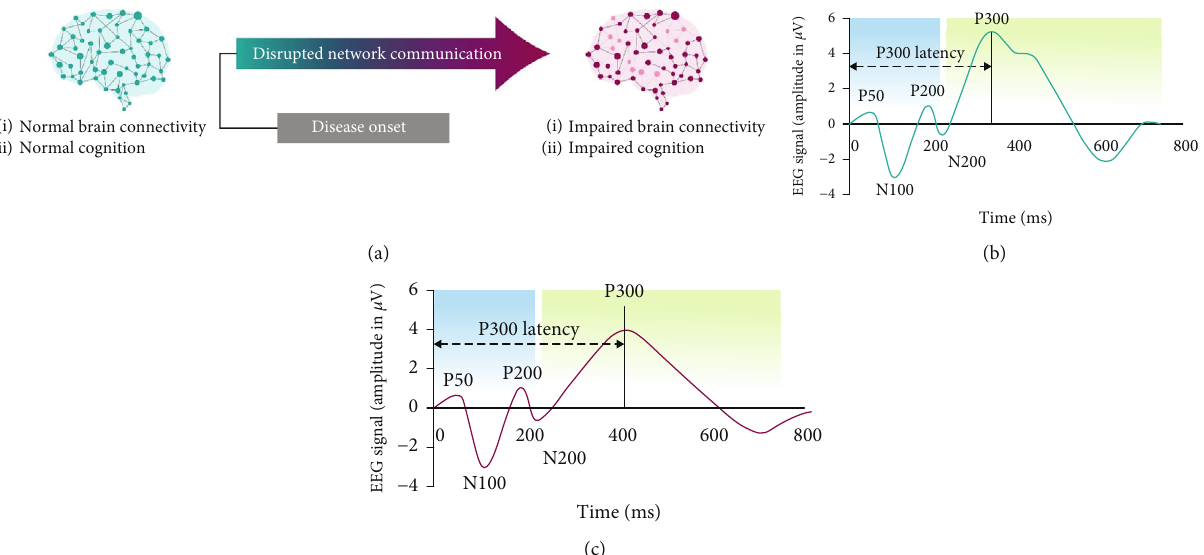
Figure 3: Schematic of the ERP P300 waveform in the progression of AD. Shown is a representative ERP waveform for neurotypical brain activity and normal cognition (b). A characteristic response is detected 300 ms after presentation of stimuli (P300). Early in disease onset, and usually prior to the diagnosis of AD, neural network communication is disrupted, leading to impaired brain connectivity and impaired cognition. This change in cognition can be detected as a change in the peak and/or latency (time to onset of peak) of the P300 response to stimuli